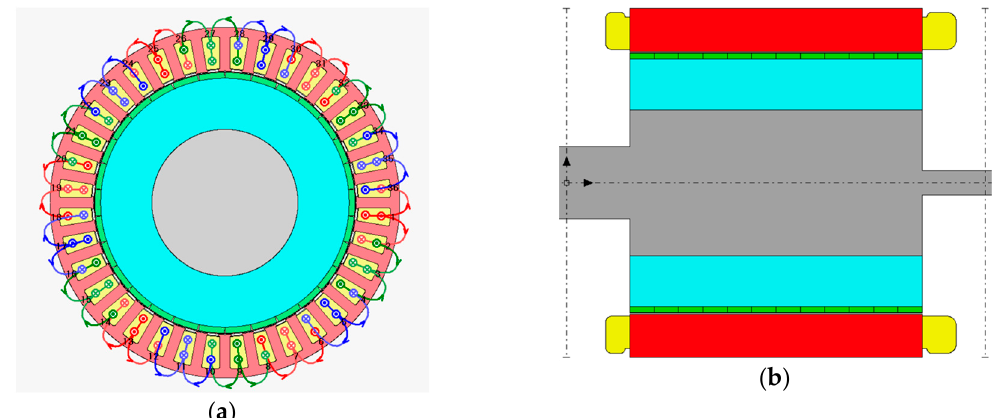
Figure 10. Magnetic wedge characteristics: ( a ) relative permeability; ( b ) magnetization characteristics.